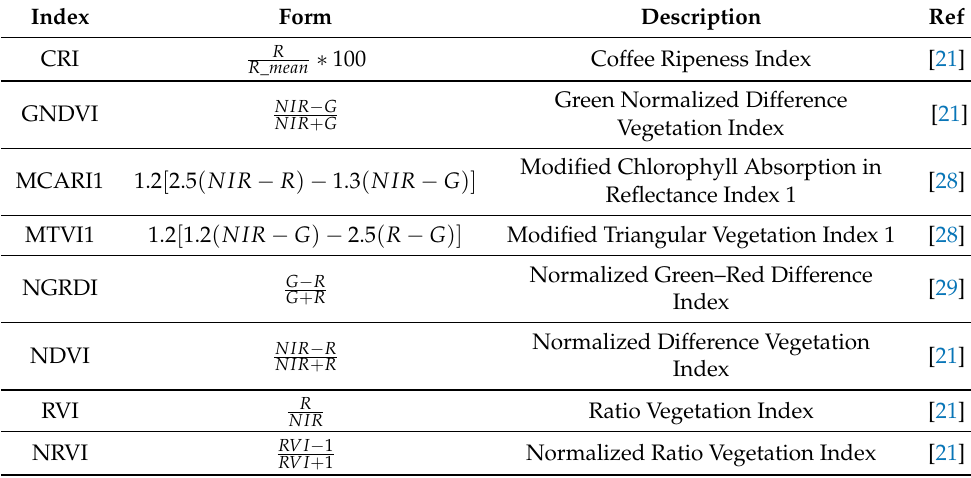
Table 1. Vegetation